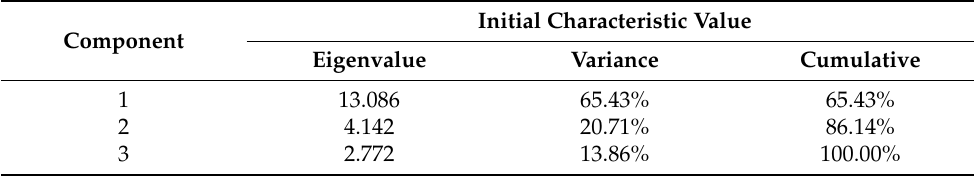
Table 3. Principal component analysis for nutritional components of N. yezoensis strains.